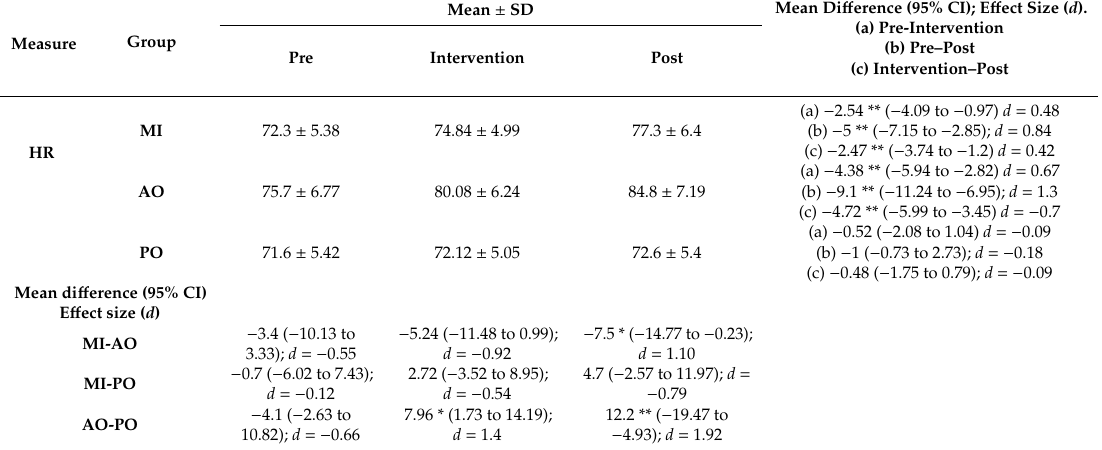
Table 4. Results of heart rate